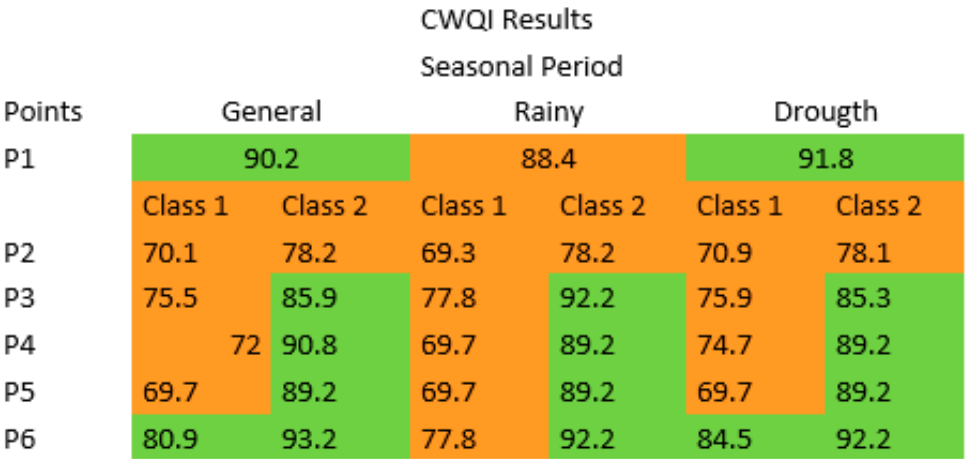
Figure 4. General water quality indices by period and for the points studied, using as a basis for the limits of the parameters established in Annex XX of Consolidation Ordinance Nº. 5 for P1 and the other points (P2 to P6) according to CONAMA resolution Nº 357 for class 1 and 2.